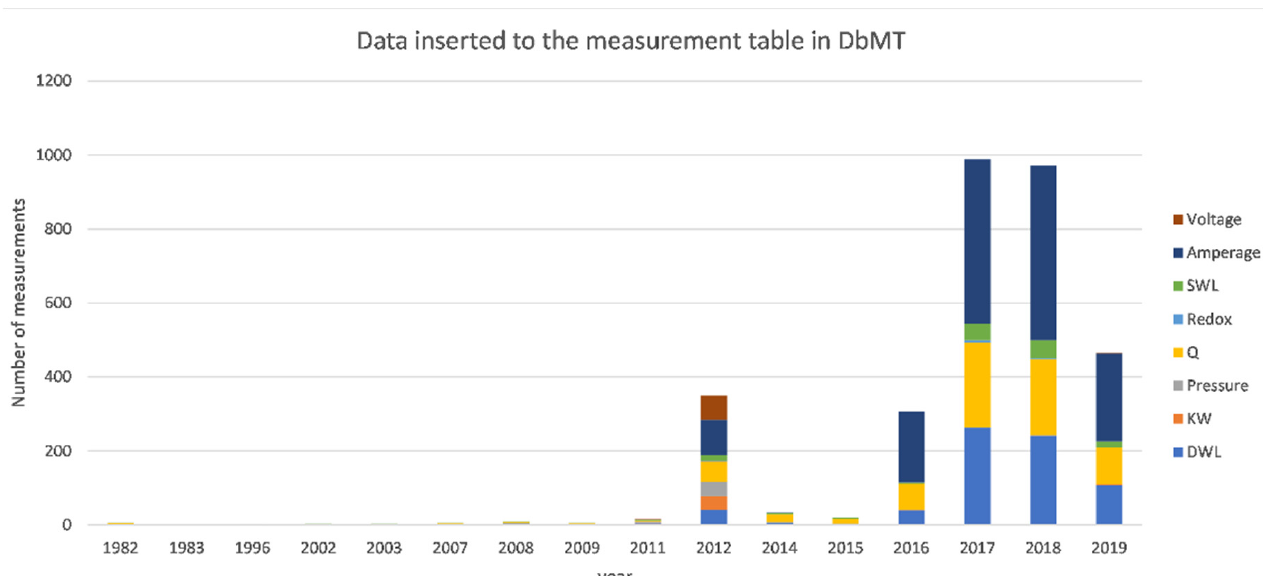
Figure 4. The collected and uploaded data to the measurement table in DbMT. List of abbreviation in the figure: SWL is static water level (m below ground level (bgl)); Q is discharge (m 3 /h), KW is the power of motor (Kilowatt); DW is dynamic water level (m bgl).